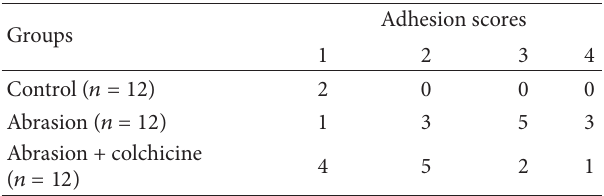
Table 1: The Z¨ulhke macroscopic